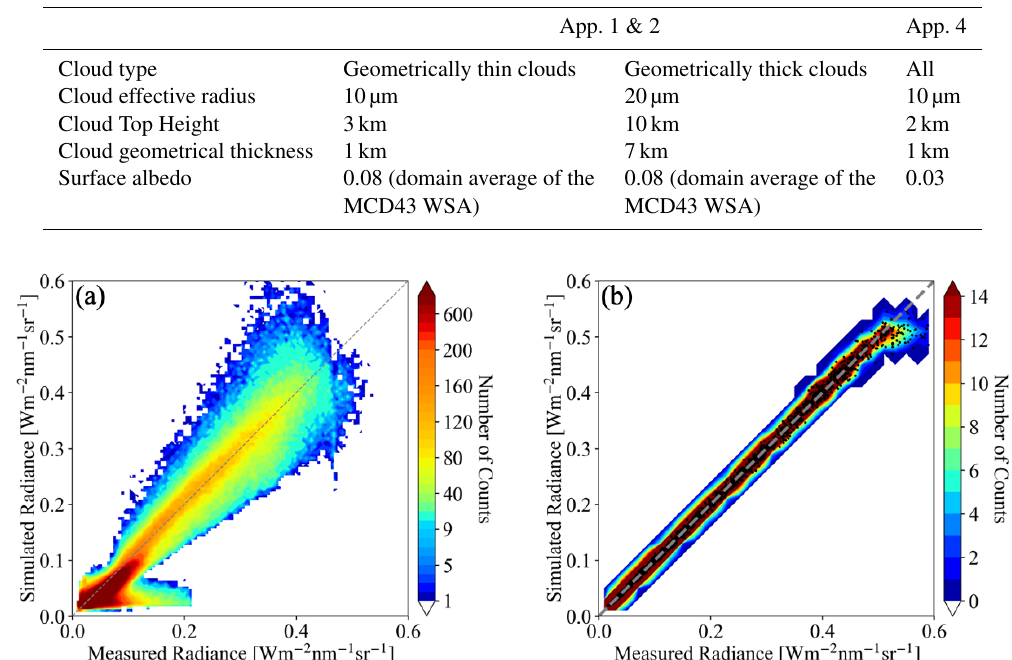
Table C1. List of parameters for deriving IPA reflectance-to-COT (cloud optical thickness) mappings for Apps. 1 and 2 and App. 4 in addition to those listed in Table A1.